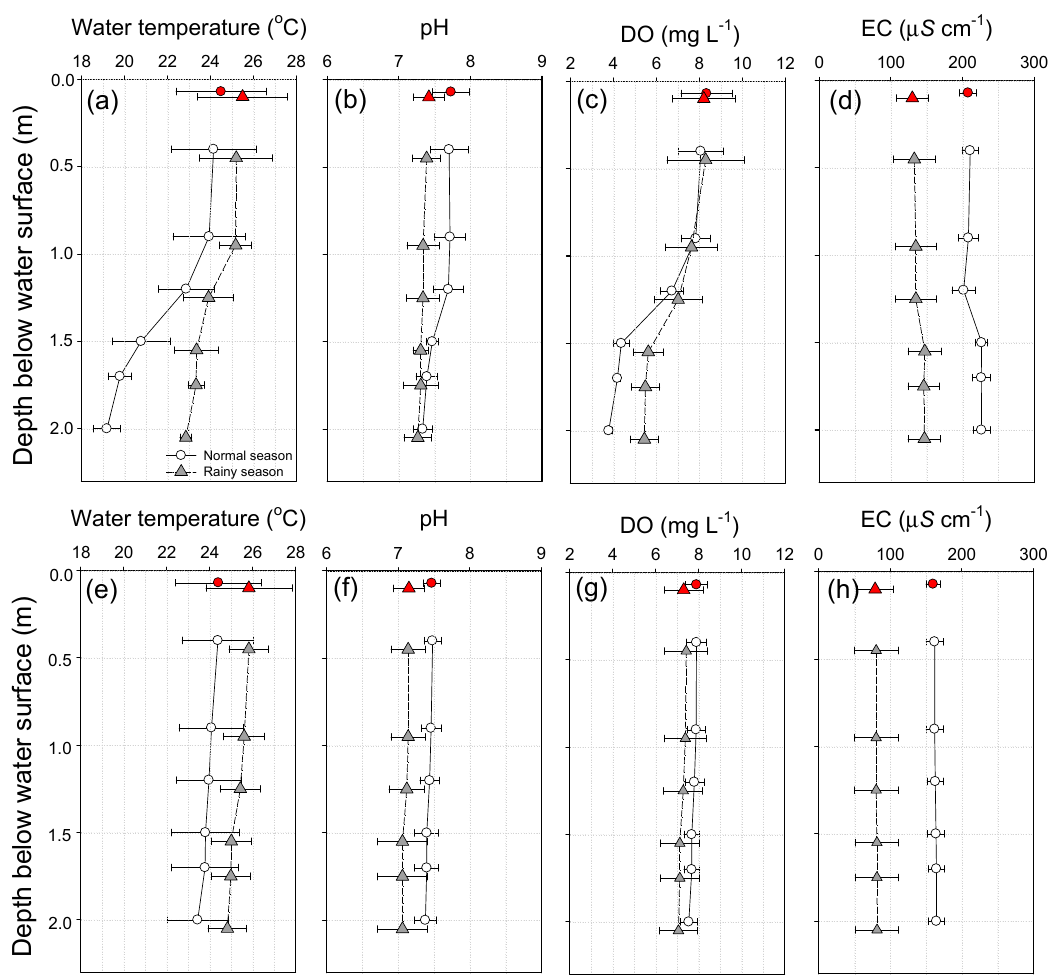
Figure 4. Vertical variations in the water temperature, pH, DO, and EC values inside the ADP under the stagnant ( a – d ; 2012) and the circulation ( e – h ; 2013) conditions by the underwater pump ( n = 10). The red dots represent 0.1 m depth of water in the open space.